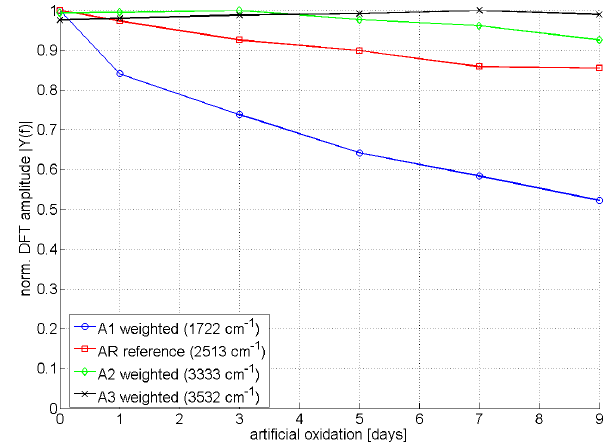
Figure 9. Measurement results for synthetic motor oil artificially aged at 170 ◦ C with 50cm 3 min − 1 air flow over 9 days, measured with a detector in mineral oil configuration (reference AR).